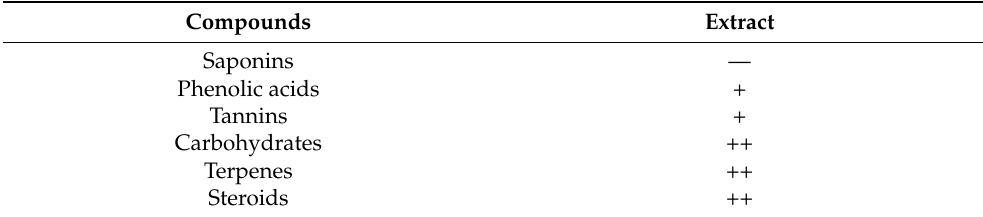
Table 2. Phytochemical screening of Agave nuusaviorum leaf